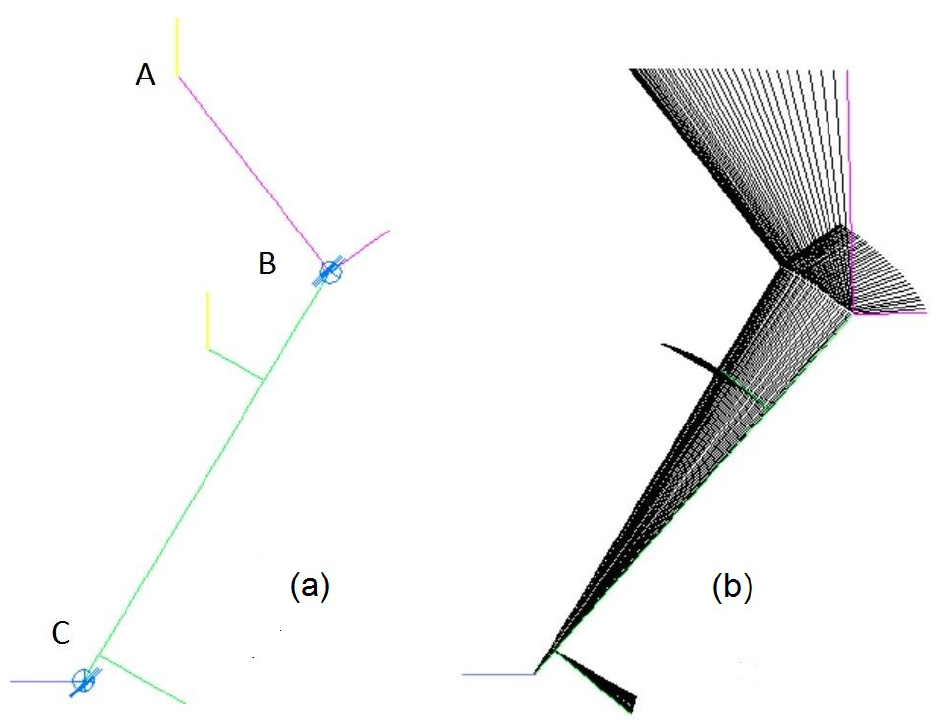
Figure 1. Calculation scheme ( a ) and motion picture ( b ) of the fall of the inverted double pendulum with the condition of horizontal movement of a given point A. A is the point for which reference motion is defined. B and C are pendulum